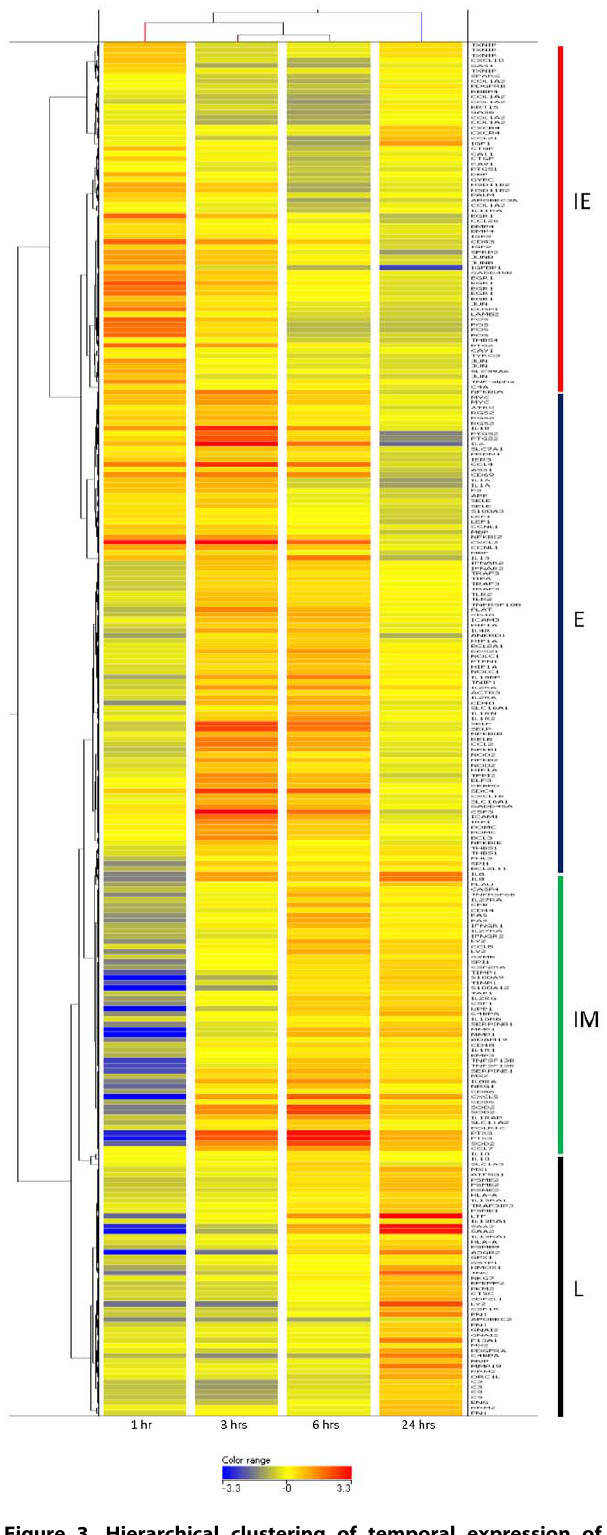
Figure 3. Hierarchical clustering of temporal expression of known and predicted NF-kB regulated genes following infec- tion with P.ovis . Clustering preformed in Genespring GX 11.0 (Agilent, UK) using the Pearson Centered distance metric. Each block represents a single gene at each time point (Control (Time =0), 1 hour, 3 hours, 6 hours and 24 hours post-infestation). Genes are colour coded by log normalised intensity values. IE = Immediate Early gene cluster, E =